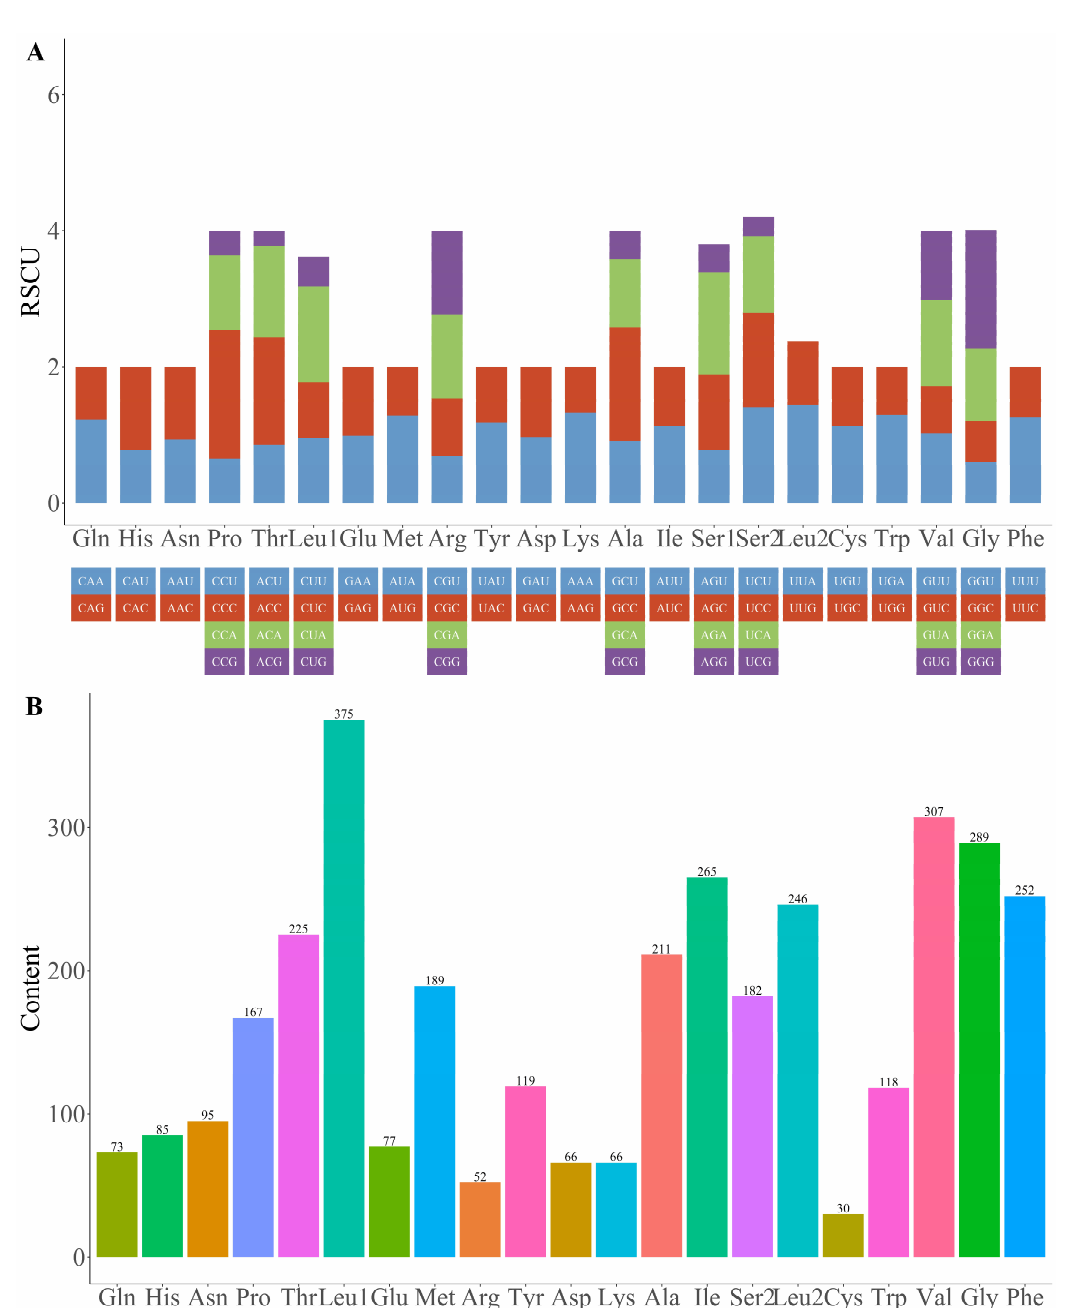
Figure 3. Relative synonymous codon usage ( A ) and codon distribution ( B ) in S. bungii mitogenome.